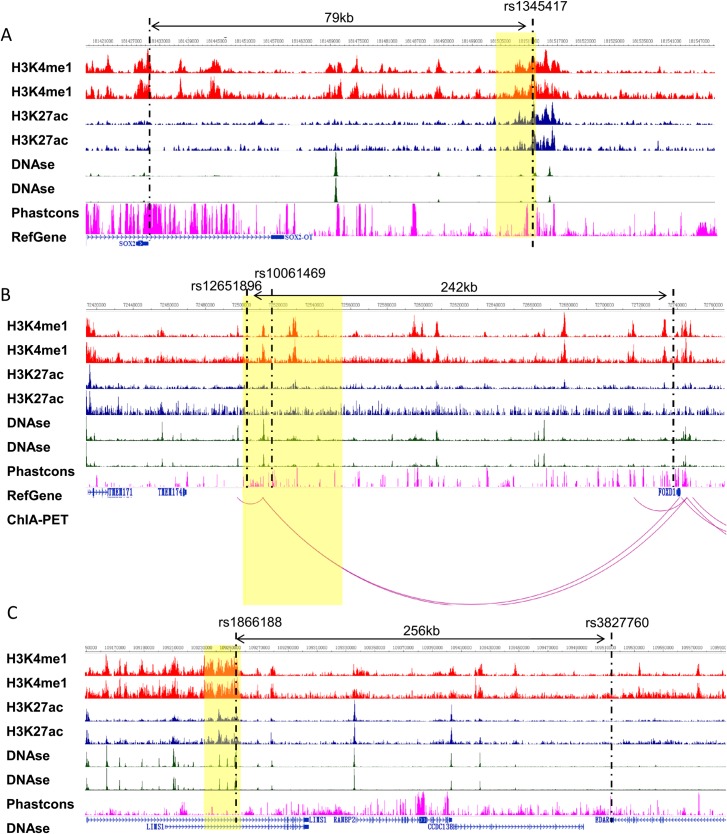
Epigenetic annotation suggests the presence of putative regulatory regions at loci associated with eyebrow thickness.Epigenetic annotation at the significantly associated regions around A) rs1345417 (3q26.33), B) rs12651896 (5q13.2) and C) rs1866188 (2q12.3), based on ENCODE and REMC project data. Regions of significant association (P<5×10−8) are denoted by a yellow box, with the top signal indicated by a black dashed line. The region exhibits distinct active enhancer signatures defined by epigenetic marks, such as H3K4me1 (red) and H3K27ac (blue) histone modifications and DNase hypersensitivity (green) in foreskin melanocyte primary cells, based on two independent biological replicates. Phastcons (pink) indicates the evolutionary conservation. ChIA-PET indicates long-range chromatin interaction. The different tracks were overlaid with physical positions using the WashU Epigenome Browser.